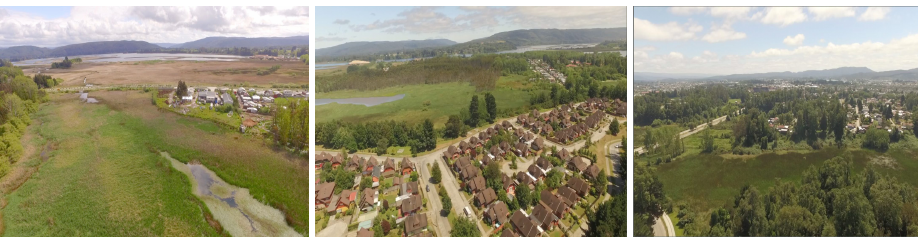
Figure 3. Angachilla ( left ), Miraflores ( center ) and El Bosque ( right ) urban